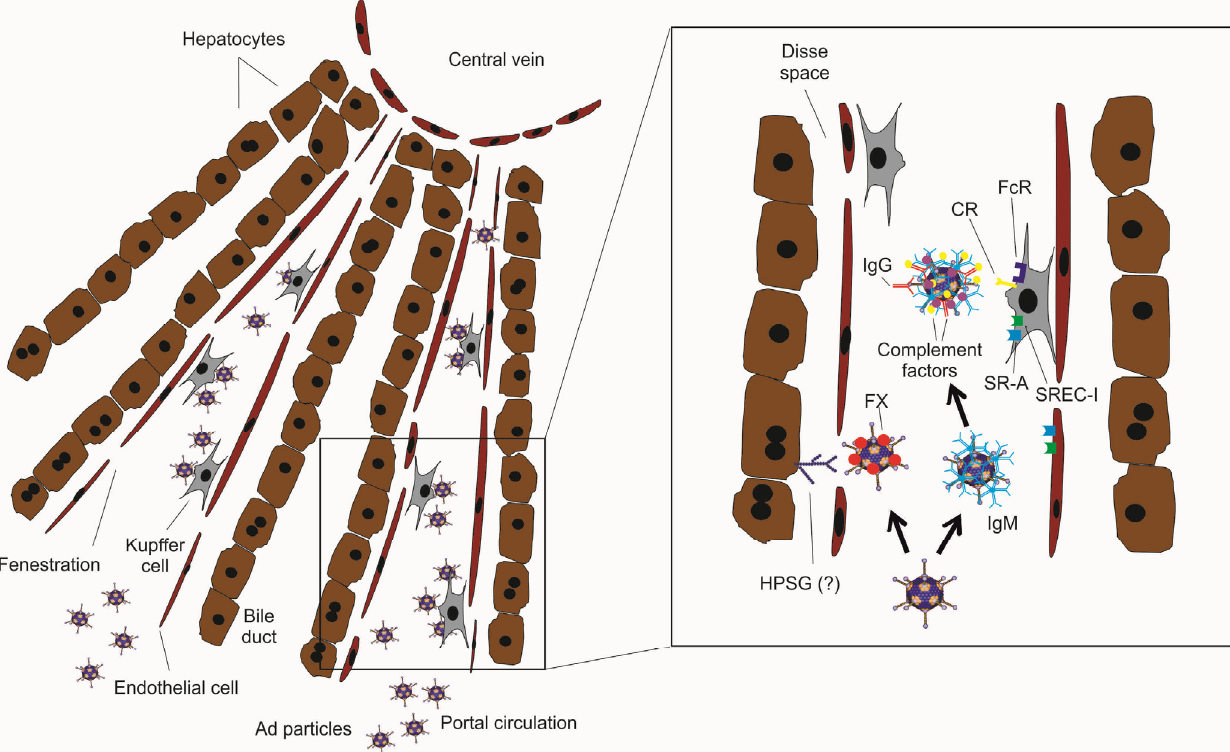
Figure 1. Schematic representation of the liver microarchitecture and the hurdles to efficient Ad vector-mediated hepatocyte gene therapy. Systemic delivery of Ad vector particles is hampered by binding of plasma proteins, Kupffer cell uptake, and limited permeability of endothelial cells. In the bloodstream, coagulation factor X (FX) binds with high affinity to the Ad capsid and protects from IgM and complement binding. Complement receptors bind to complement proteins bound either directly or indirectly to Ad particles. Vector particles osponized by pentameric IgM, monomeric IgG, or complement factors are recognized by different receptors (FcR, CR) on Kupffer cells. Kupffer cells and endothelial cells also express SR-A and SREC-I that bind Ad5 particles based on negative-charge interactions. The size of liver sinusoidal fenestrations affects the efficiency of Ad-mediated hepatocyte transduction. Abbreviations: HPSG, heparan sulfate proteoglycans; FX, factor X; FcR, Fc-receptor; SR-A, scavenger receptor-A; SREC-I, scavenger receptor expressed by endothelial cells 1; CR, complement